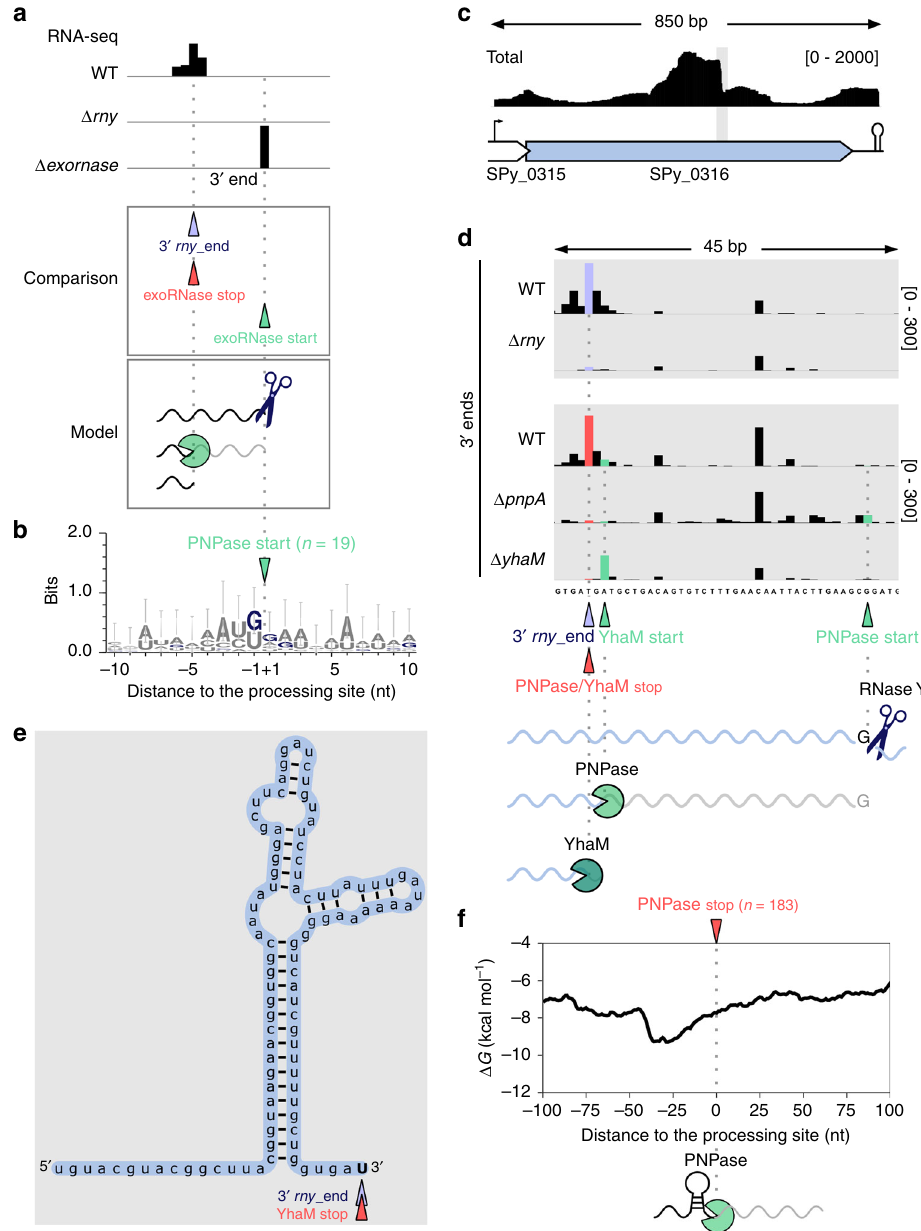
Fig. 3 RNase Y-generated RNAs are degraded by PNPase until secondary structures are encountered. a Upper panel: example of 3 ′ end coverage pro fi ling from RNA sequencing. Middle panel: the RNA ends that were more abundant in the WT than in the Δ rny strain are indicated below the coverage and depicted with purple arrowheads (3 ′ rny _ends). The RNA ends corresponding to the trimming start and stop positions of exoRNases are depicted with green and red arrowheads, respectively (see Supplementary Fig. 1). The 3 ′ rny _ends were paired to 3 ′ -to-5 ′ exoRNase stop positions (Supplementary Data 2 and Fig. 2, bottom). Bottom panel: the 3 ′ -to-5 ′ exoRNases ( ‘ pacman ’ symbols) started trimming upon RNase Y (scissors) processing and stopped before the RNA termini. The 3 ′ rny _ends corresponding to the 3 ′ -to-5 ′ exoRNase stop positions were compared with the exoRNase trimming start positions located downstream. The 3 ′ -to-5 ′ exoRNase start position corresponds to the initial RNase Y processing position (Supplementary Data 3). b The logo, displaying the information (bits), was created from the alignment of all sequences surrounding the 19 identi fi ed PNPase trimming start positions. c Total coverage of SPy_0316 (encoding a putative transcriptional regulator) in WT obtained by RNA sequencing, and schematic representation of the locus. The grey rectangle indicates the region where the processing sites of RNase Y, PNPase and YhaM were identi fi ed. d 3 ′ end coverage of a portion of SPy_0316 in the WT, Δ rny , YhaM deletion mutant ( Δ yhaM ) and PNPase deletion mutant ( Δ pnpA ) strains. The coverage scales are indicated between brackets. RNase Y processed the RNA after a G, corresponding to the detected PNPase trimming start position. PNPase trimmed 34 nt of the SPy_0316 RNA 3 ′ end. This new RNA 3 ′ end was subsequently nibbled by YhaM. e RNA folding of the region 100 nt upstream of the 3 ′ rny _ends corresponding to YhaM trimming stop positions. YhaM started trimming after PNPase stopped, at the base of the stem loop structure, and consequently removed 2 nt from the RNA 3 ′ end. f Structure conservation at the 183 PNPase stop positions previously identi fi ed 17 . The decrease in the minimum free energy ( Δ G, kcal mol − 1 ) is indicative of RNA structures likely preventing PNPase from degrading the